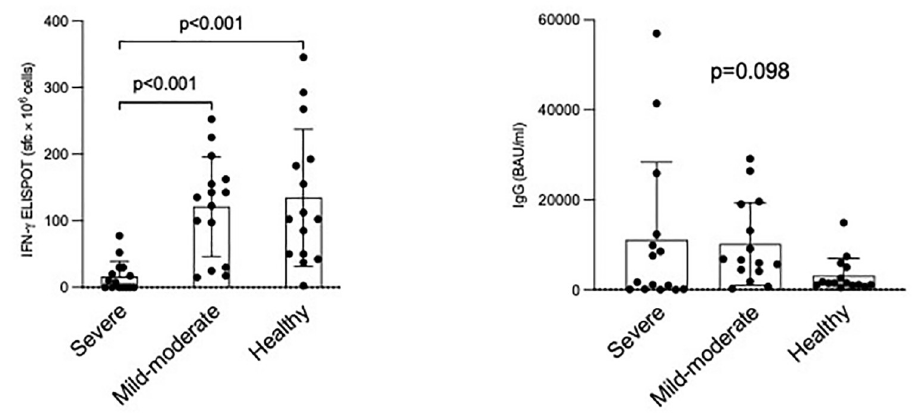
Fig 1. The frequencies of spike-specific IFN- γ releasing cells and the titers of IgG measured in our cohorts of cases are depicted on the left and right, respectively. The bottom and top of the box indicate the 25 th and 75 th percentiles, respectively. The horizontal band close to the middle of the box represents the median, whereas the ends of the whiskers represent the 10 th and 90 th percentiles. P values within study cohorts are also reported. https://doi.org/10.1371/journal.pone.0281444.g001 significantly lower in SARS-CoV-2 severe patients requiring hospitalization (8 [0; 26] s.f. c. × 10 6 ), as compared to COVID-19 mild-moderate patients (135 [64; 159] s.f.c. × 10 6 ; p < 0.001) and healthy subjects (103 [50; 188] s.f.c. × 10 6 ; p < 0.001). No difference was recorded between mild-moderate patients and healthy subjects (p = 0.852). Conversely, the anti-Spike protein IgG (p = 0.098) levels were similar among the three cohorts of cases. In particular, IgG (BAU/ ml) titers were 1670 [124; 12300] in severe patients, 6600 [4100; 19000] in mild-moderate